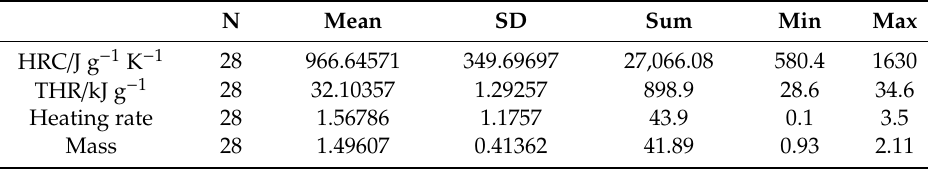
Table 3. Analysis of variance for HRC.